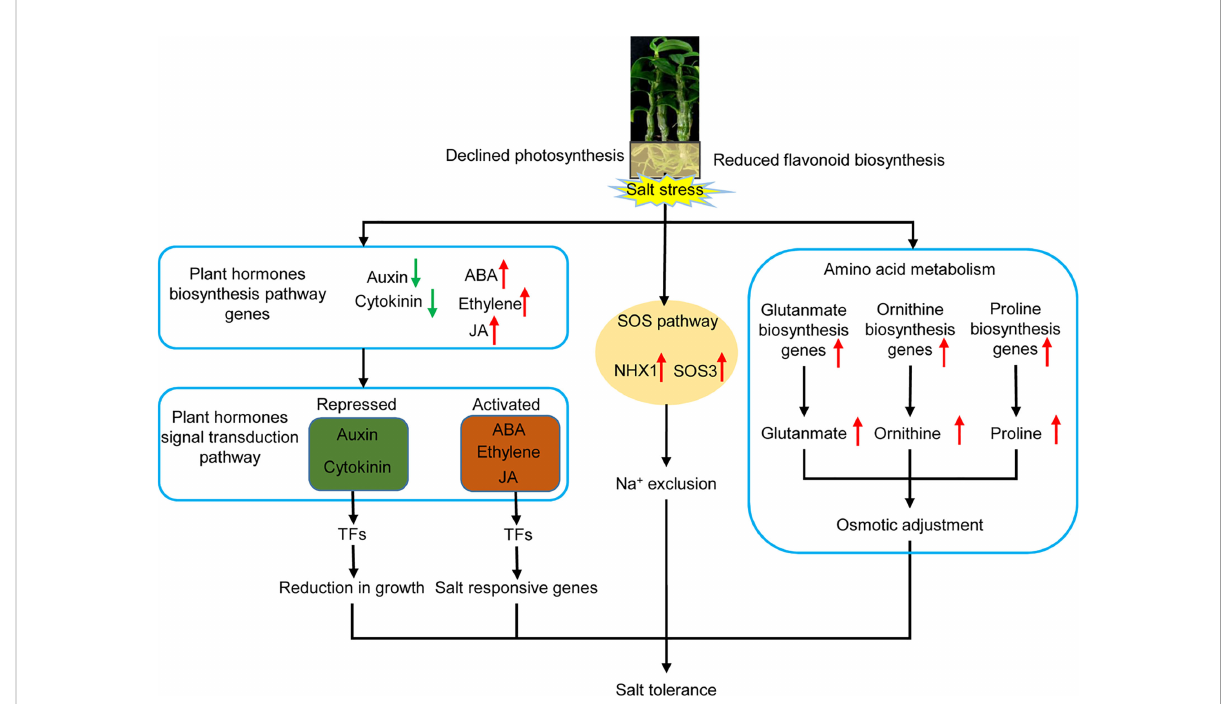
FIGURE 11 Schematic diagram of the response mechanism of D . of fi cinale roots under salinity stress. Upward-facing red arrows represent activated/up- regulated targets. Downward-facing green arrows represent repressed/down-regulated